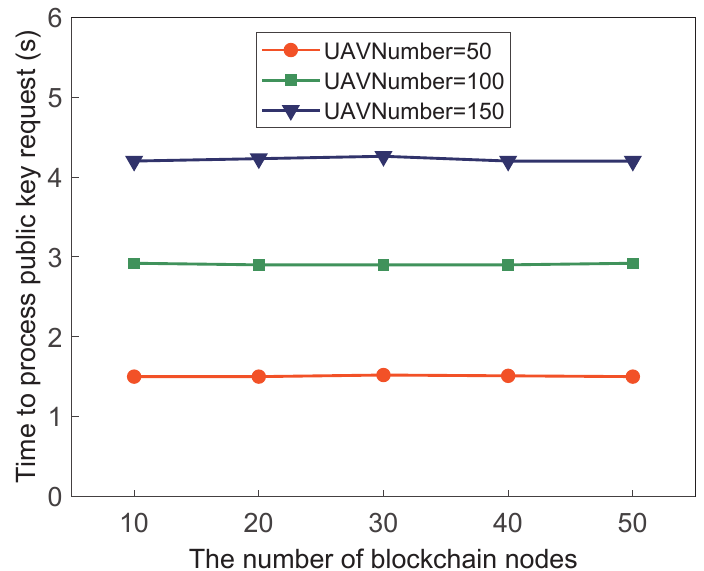
Figure 7. Public key request time according to the number of blockchain nodes.